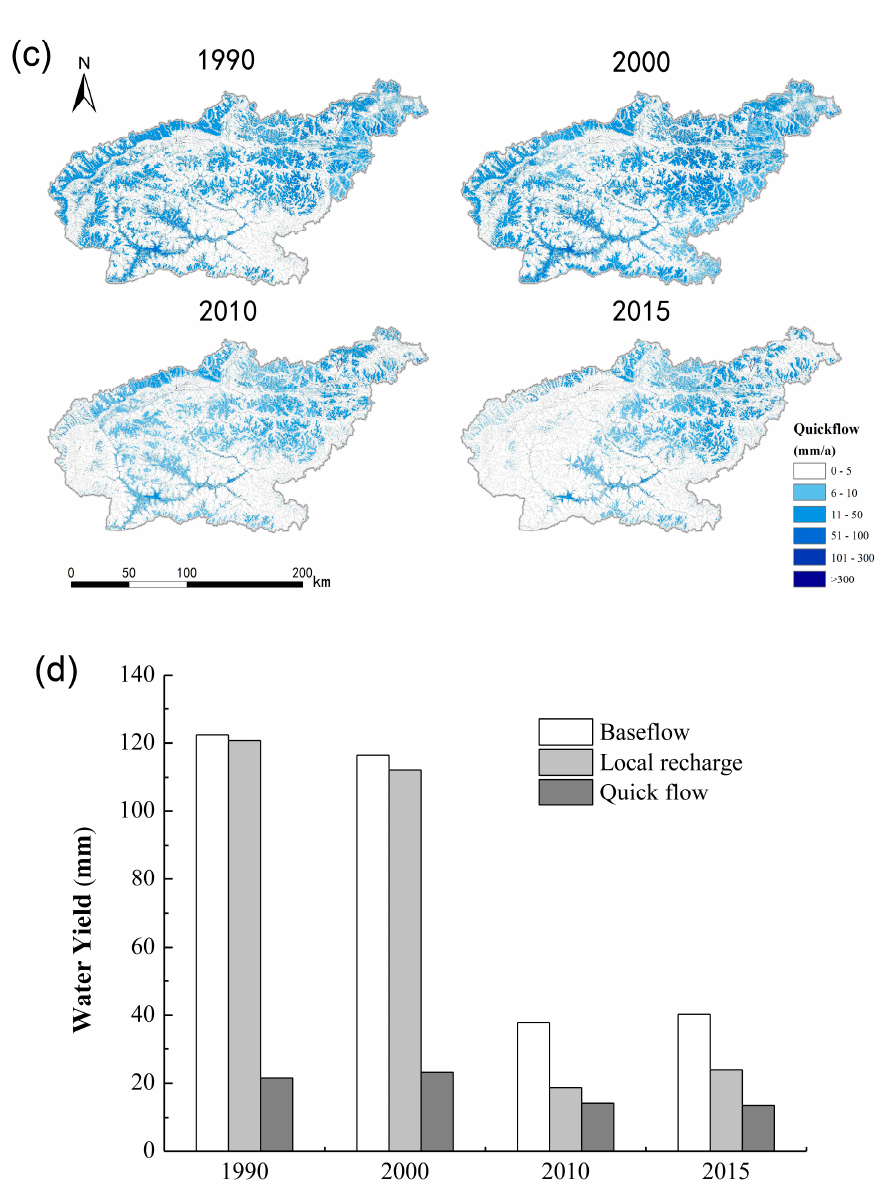
Figure 7. Spatial distribution of ( a ) baseflow, ( b ) local recharge, ( c ) quick flow, and ( d ) total amount.